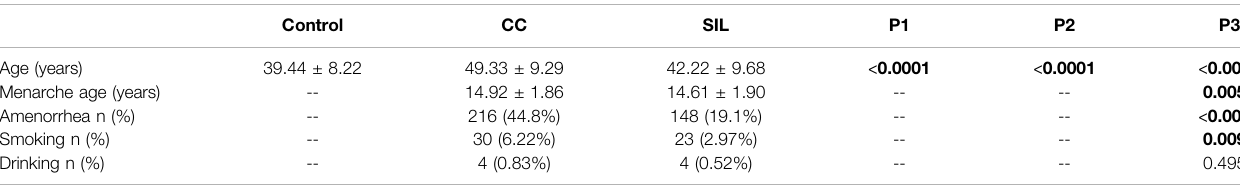
TABLE 1 | Clinical characteristics in the control group with the CC and SIL groups.